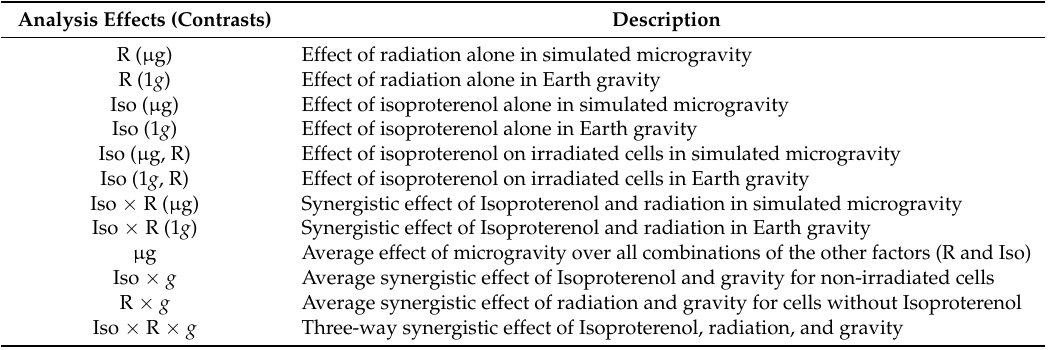
Table 7. Nomenclature for experimental factors and analyzed